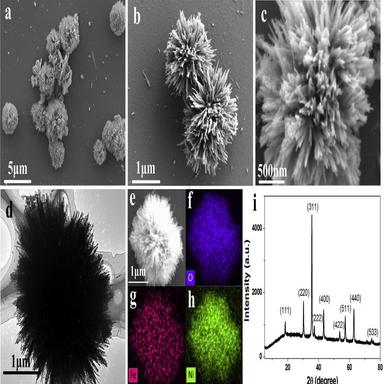
SEM images with different magnifications (a, b, c), TEM image (d), EDS mapping (e, f, g, h) and XRD patterns (i) of PF-NiFe2O4.